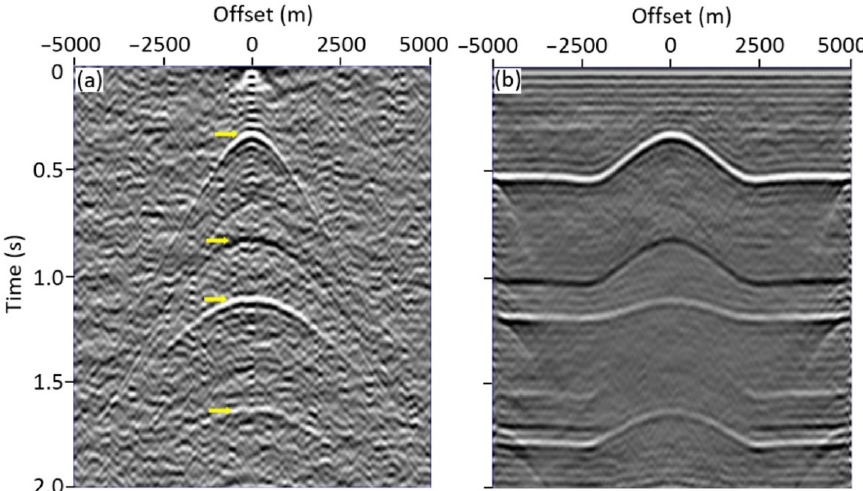
Figure 8. ( a ) A virtual shot gather retrieved at position of receiver 101 and ( b ) the final stacked section retrieved from the surface acquisition scheme. The yellow arrows correspond to the reflections from four interface in Figure 7.